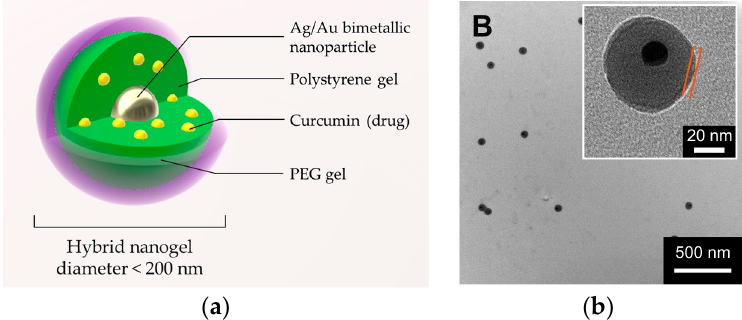
Figure 5. The hybrid nanogel prepared by Zhou [77]: ( a ) Schematic representation and ( b ) TEM image which evidenced the shell thickness. Image ( b ) reprinted from Reference [77] Copyright (2011), with permission from Elsevier.